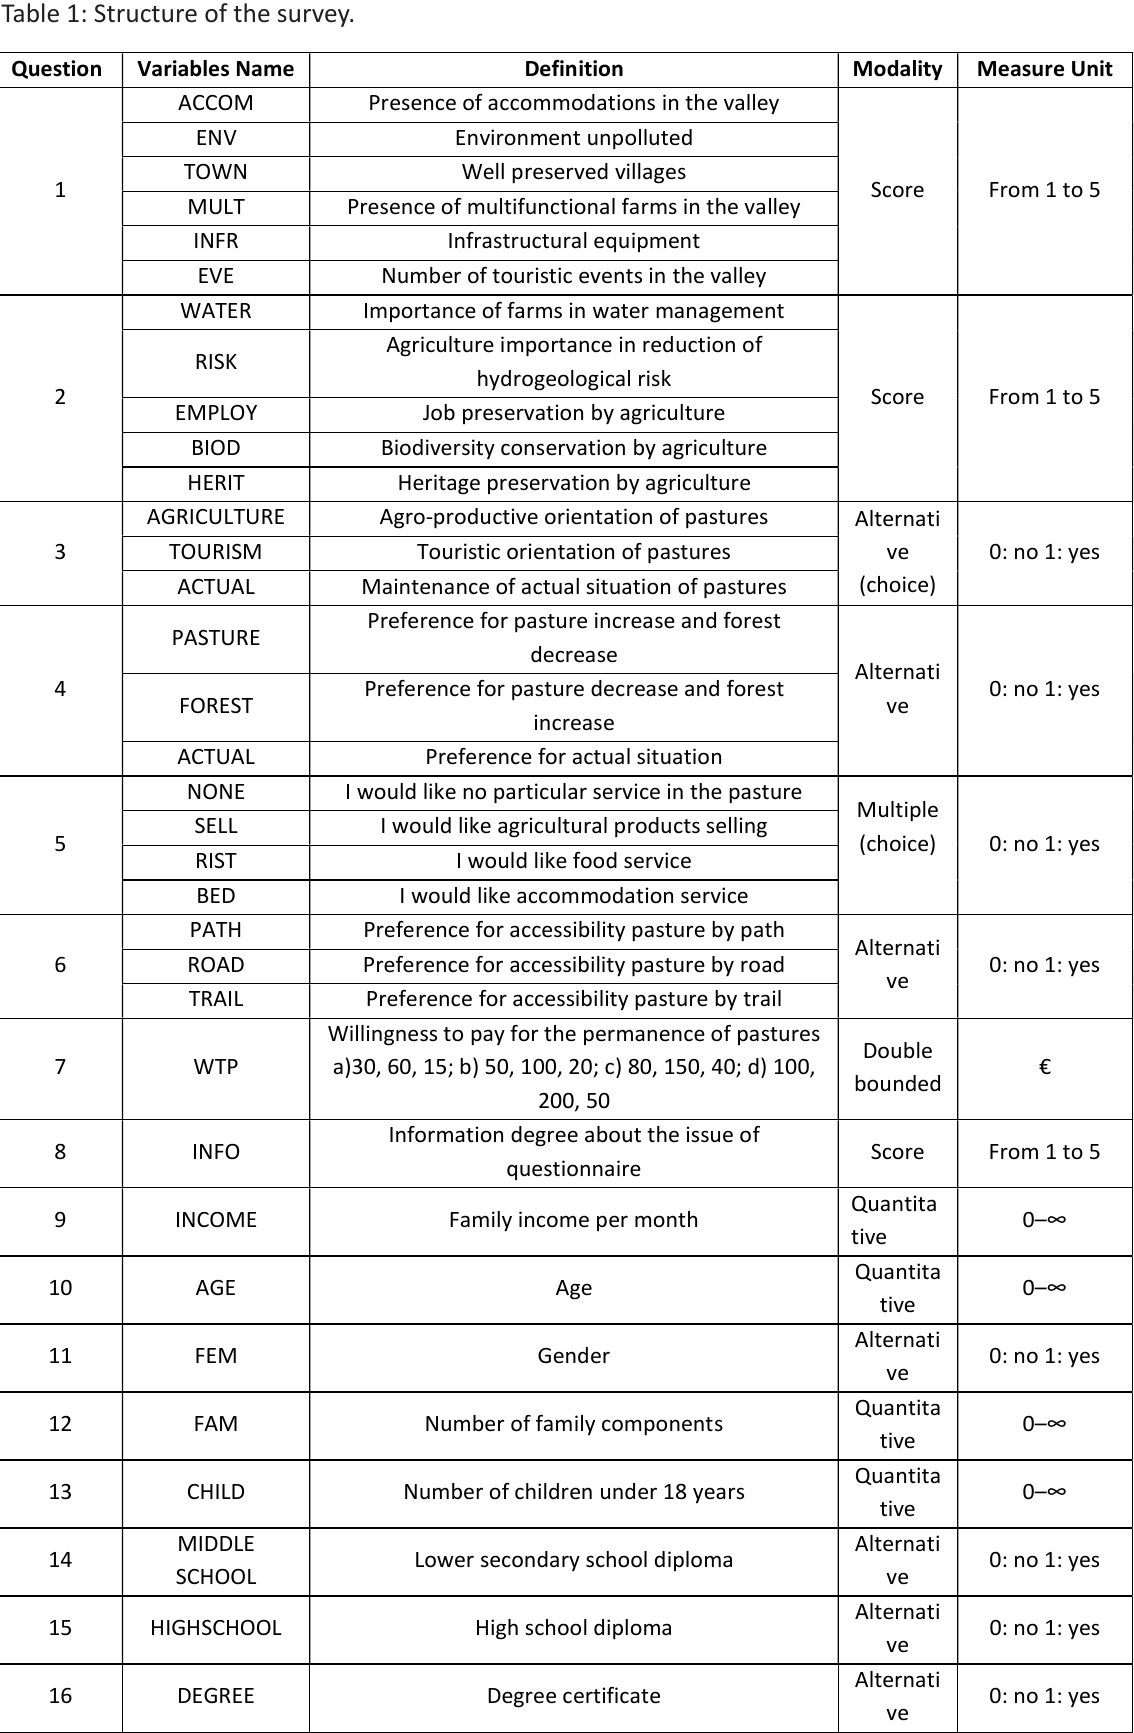
Table 1: Structure of the